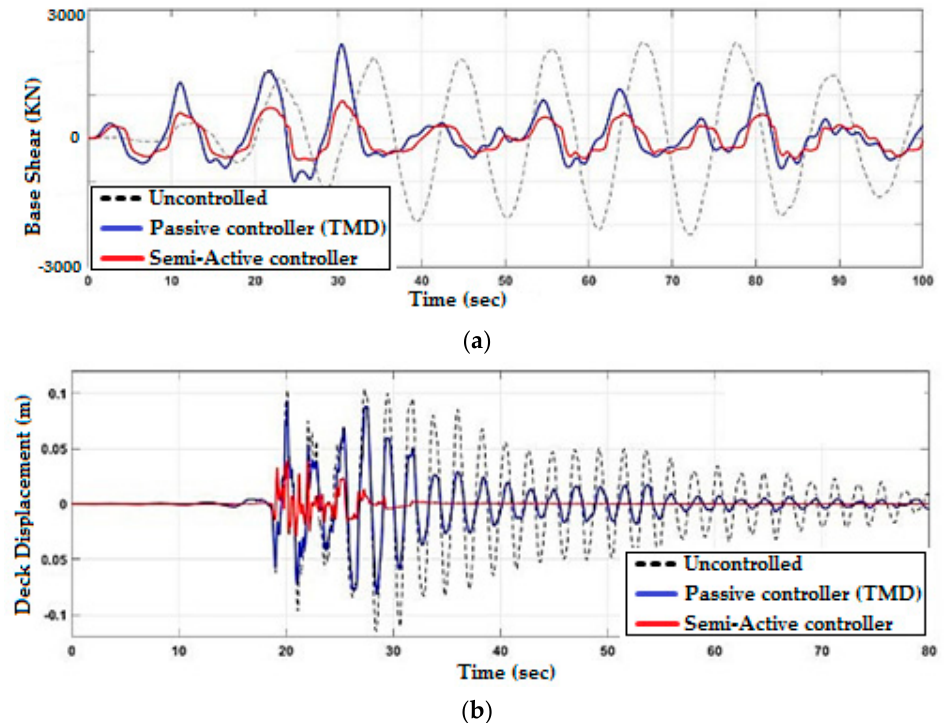
Figure 8. Comparison of the tuned mass damper with semi-active tuned mass damper [39]. ( a ) Base shear reduction via environmental loading, ( b ) The main deck lateral deflection under earthquake load.